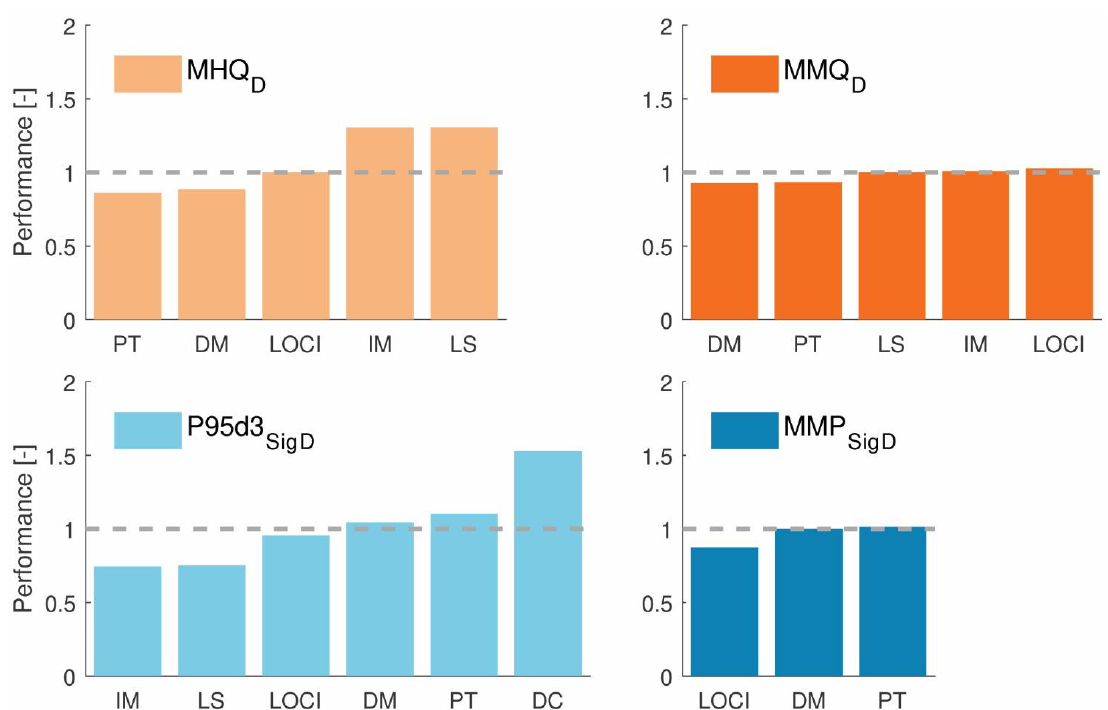
Figure 6. Performance of different bias correction methods in terms of (upper charts): MHQ and monthly mean values of discharge and (lower charts): the climate change signals for the 95% percentile of 3-day precipitation sum, P95d3 SigD , and for the monthly mean precipitation MMP SigD . Evaluated BC methods: LS = linear scaling, PT = power transformation, DM = distribution mapping, IM = the ISI-MIP approach, DC = delta change and LOCI.